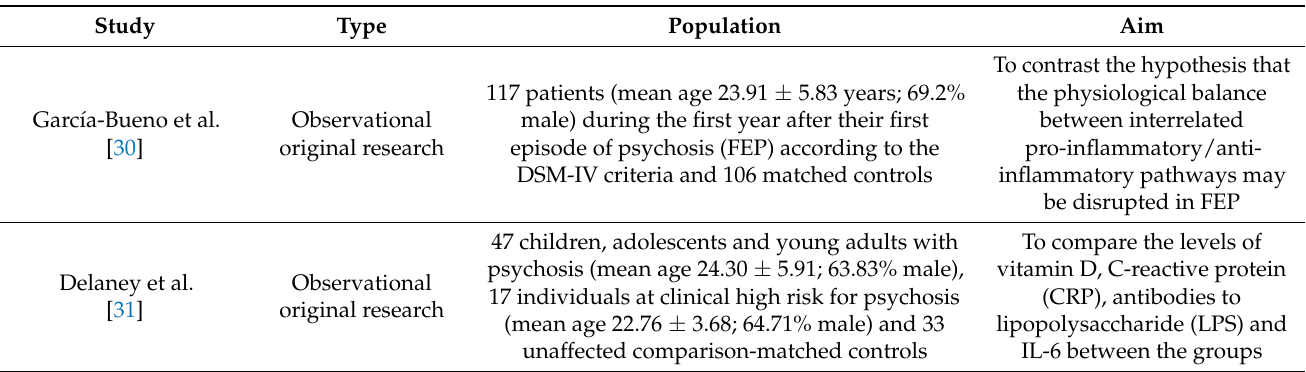
Table 1. Reviewed studies in psychotic